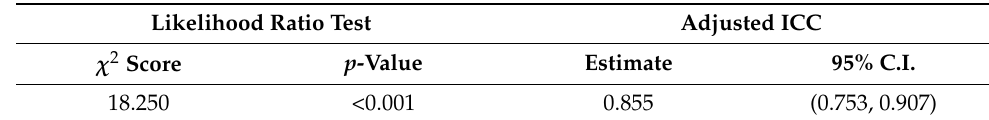
Table 4. Likelihood ratio test and intraclass correlation coefficient for the interobserver reproducibility study. ICC, Intraclass Correlation Coefficient; C.I., Confidence Interval.